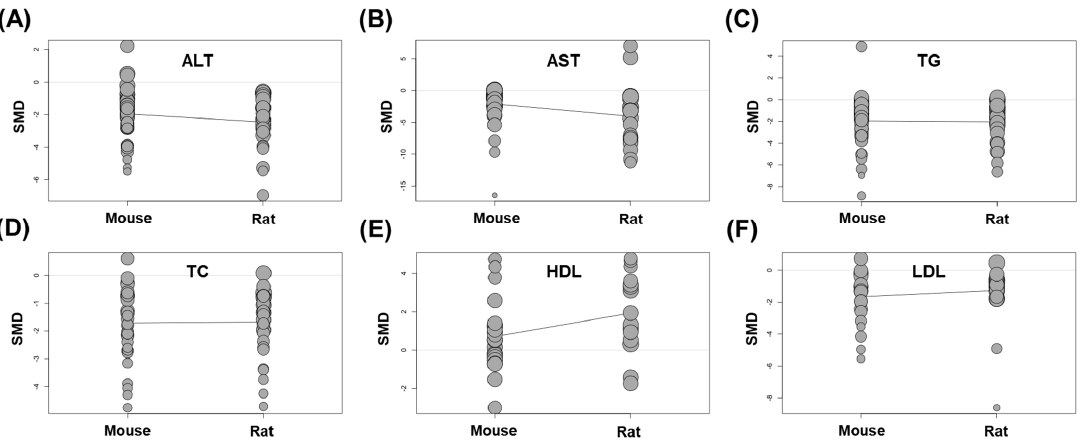
Figure 7. Effects of Panax ginseng on NAFLD according to animal species. Bubble plots with the fitted meta-regression lines for comparison: ( A ) ALT levels [7,19,20,23,27–32,35–41,43–45,47–50,52,54–56,58]. ( B ) AST levels [19,23,27–32,35–41,44,45,47–50,52,54–56,58]. ( C ) TG levels [7,19–30,32–35,38–41,44,46–